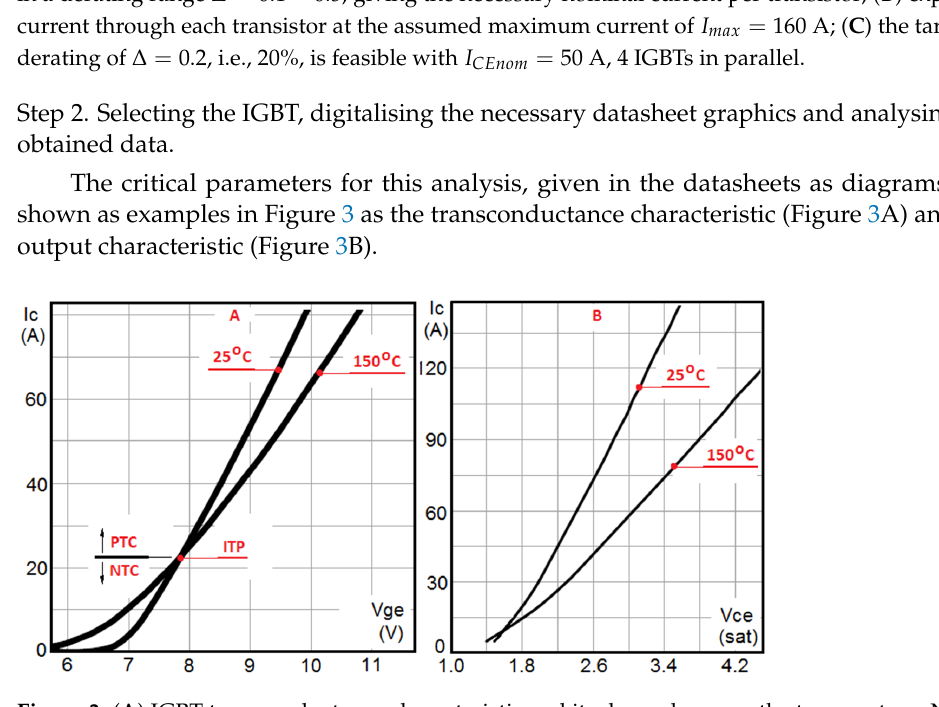
Figure 3. ( A ) IGBT transconductance characteristic and its dependence on the temperature; NTC— Negative Thermal Coefficient; PTC—Positive Thermal Coefficient; ITP—Isothermal Point; ( B ) IGBT output characteristics and its dependence on the temperature.